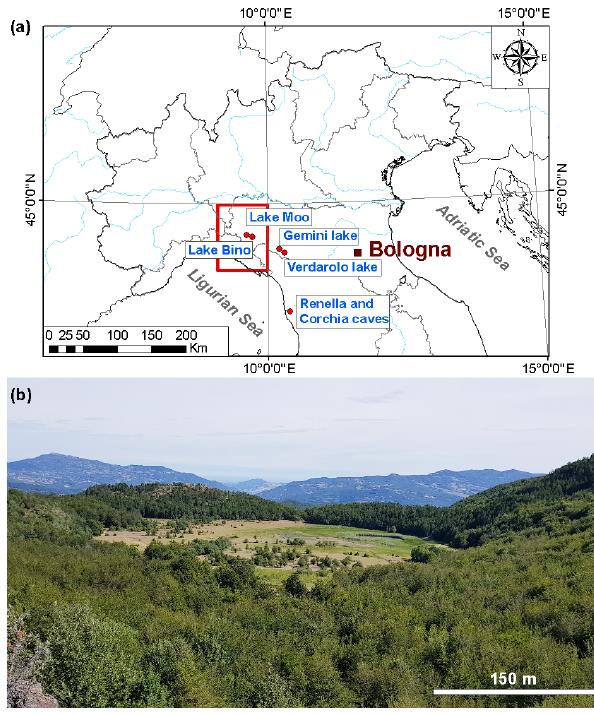
Figure 1. (a) Location map of the Lake Moo plain. The area af- fected by the extreme precipitation event of 13 and 14 September 2015 is highlighted by the red rectangle. (b) View of the Lake Moo landscape from the southern